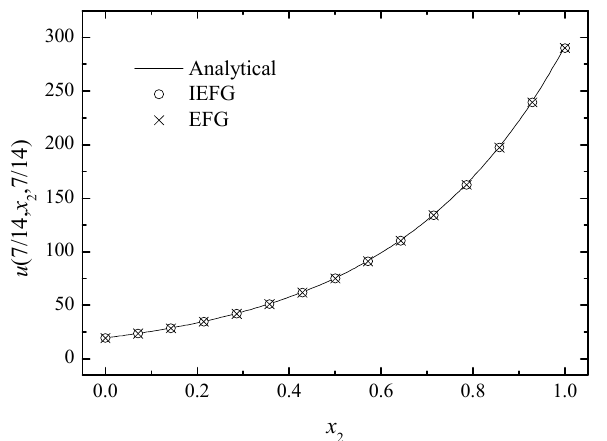
Figure 11. The comparison of the numerical and analytical solutions of the two methods along the x 2 -axis.